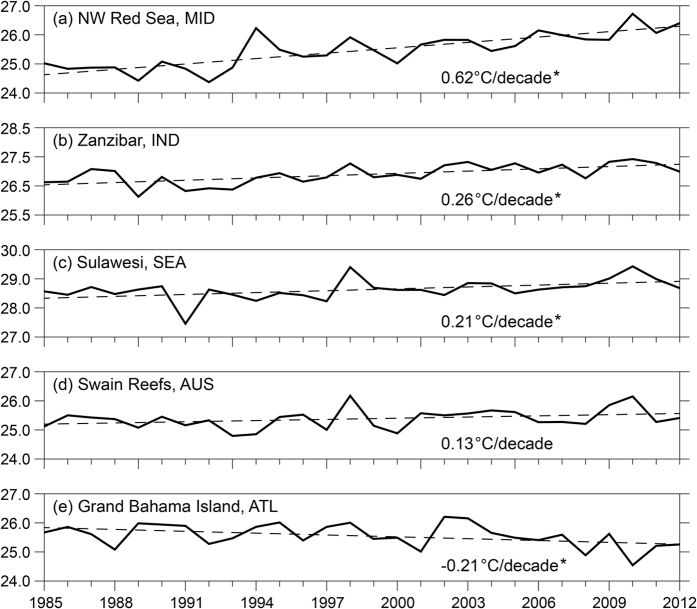
Trends in annual mean temperature at select coral reef locations.These locations approximate the 99th, 75th, 50th, 25th, and 1st percentiles (a–e, respectively) of the annual SST Trend values in the global dataset (n = 60,710 reef pixels). Reef regions are MID = Middle East, IND = Indian Ocean, SEA = Southeast Asia, AUS = Australia and ATL = Atlantic Ocean). Trend values shown are significant (p < 0.05, denoted by*) excepting for Swain Reefs, AUS.